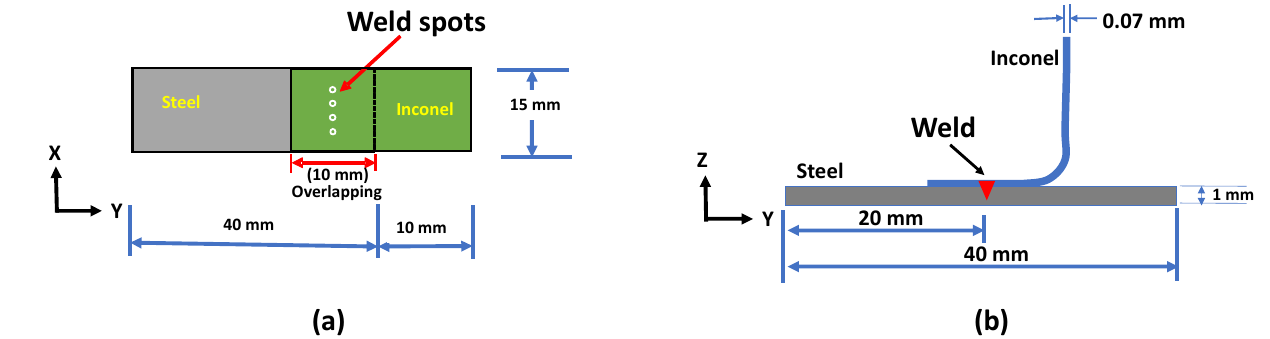
Figure 1. Schematic of tensile sample ( a ) lap shear specimen and ( b ) 90° peel specimen (sectional schematic view). Table 1. Chemical composition (wt%) of work materials similar materials are used in [33,38].